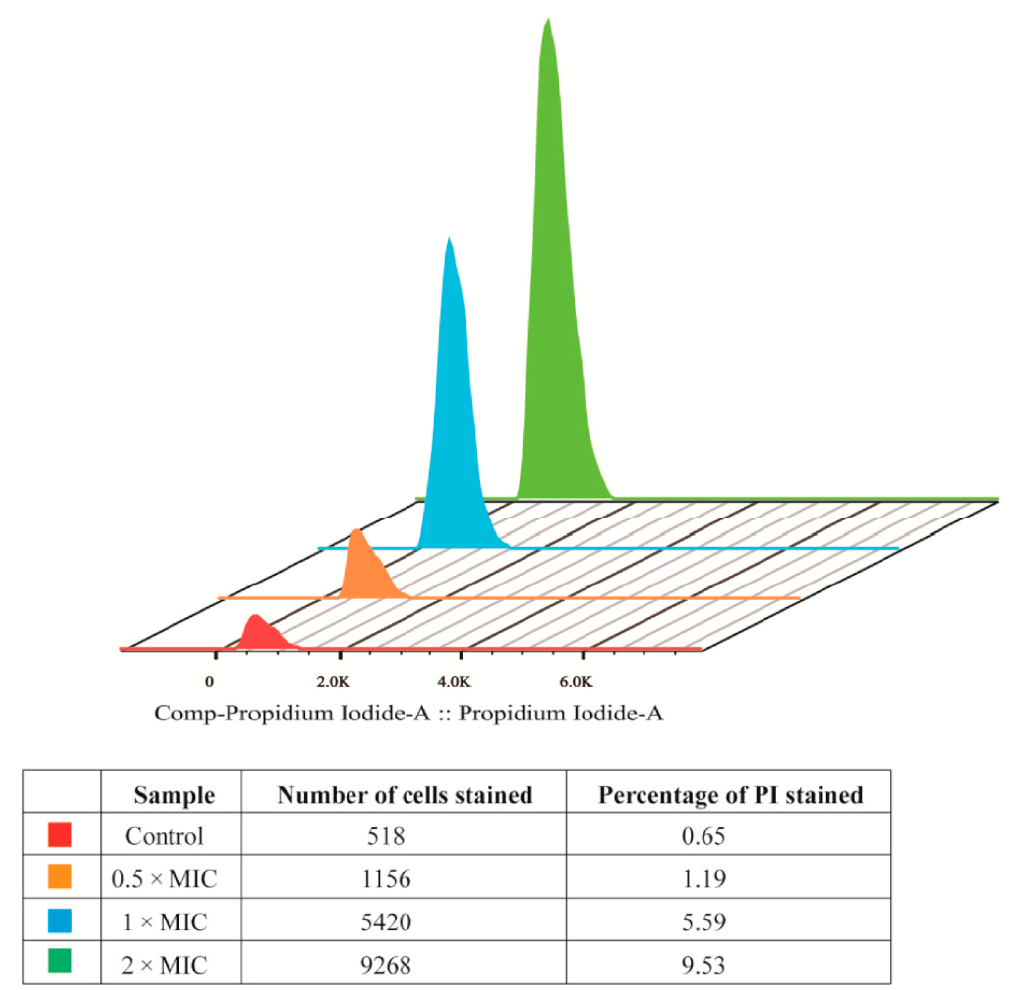
Figure 3. Fluorescence plots of L. monocytogenes stained with propidium iodide